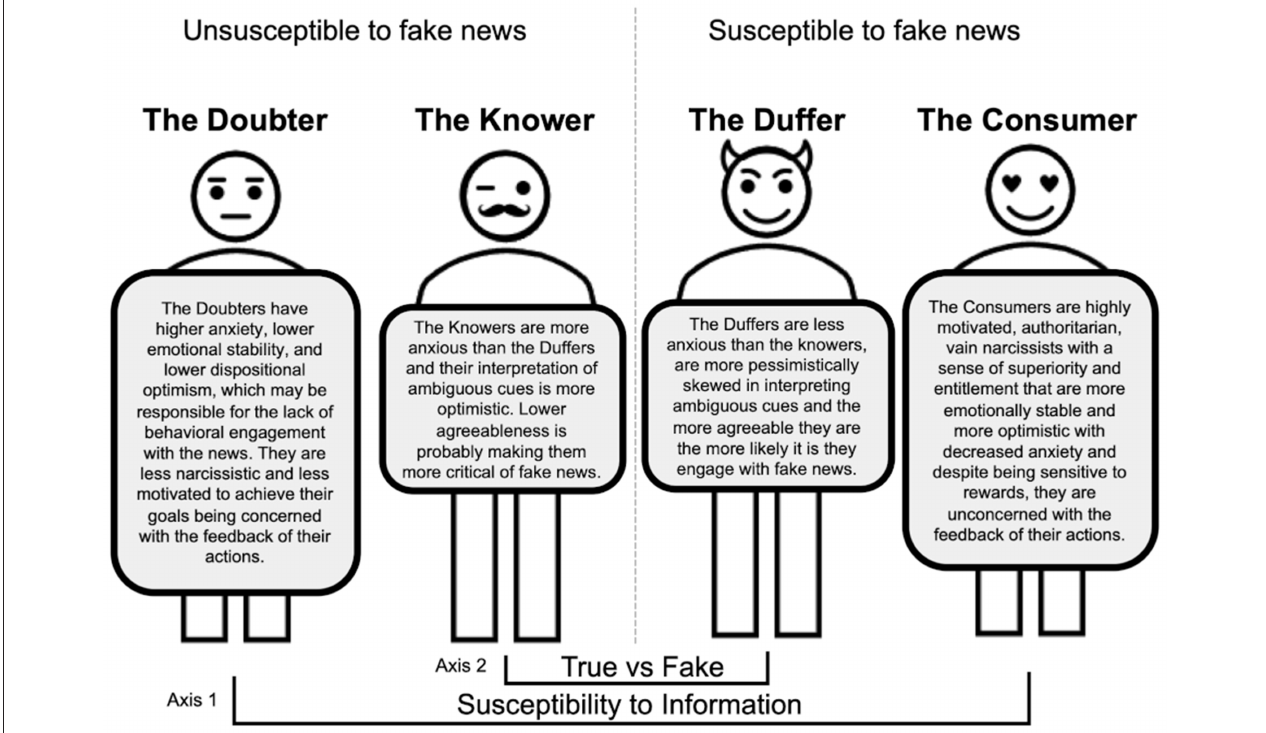
FIGURE 12 | Psychological profiles of the phenotypes of susceptibility to (mis)information.